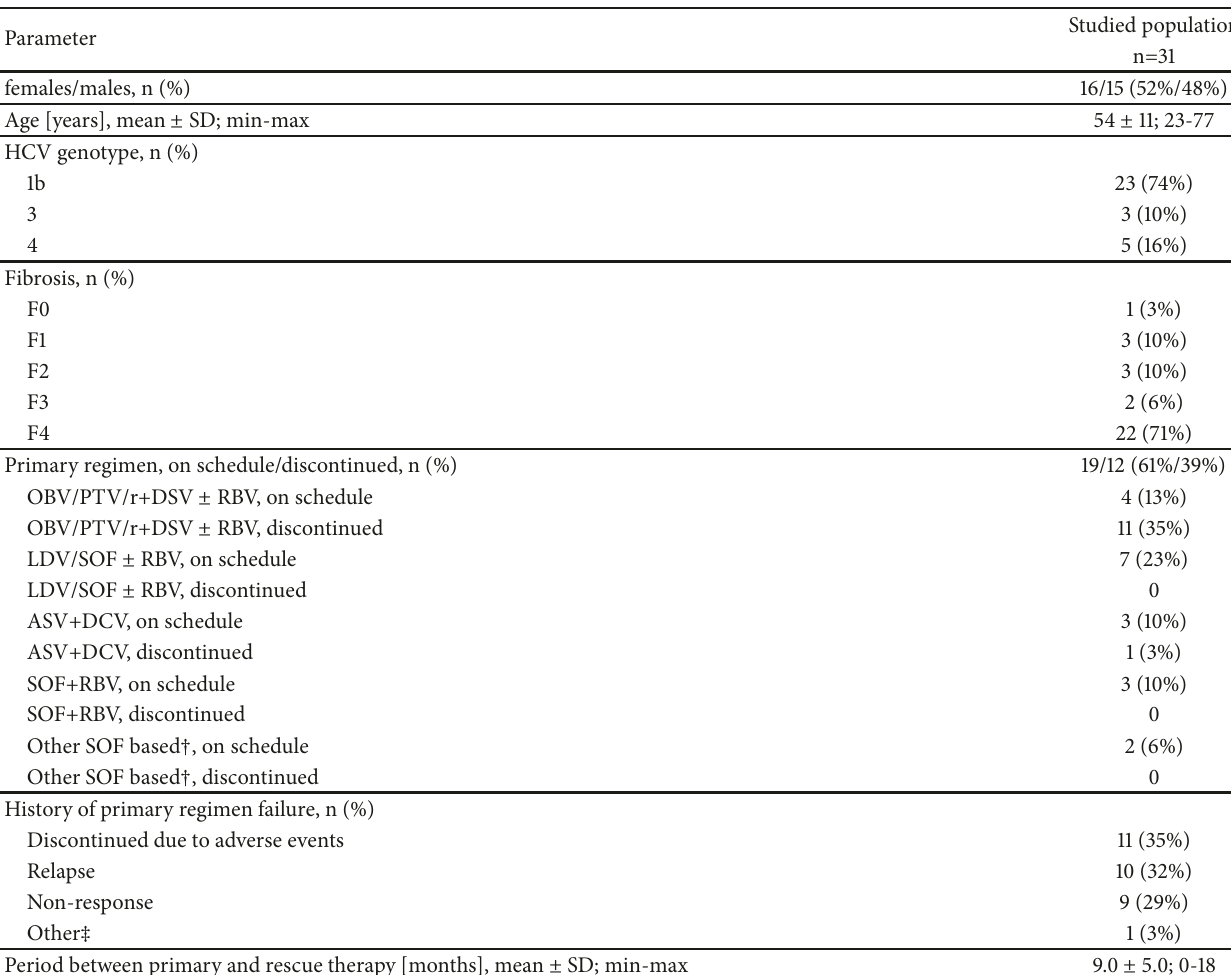
Table 1: Characteristics of nonresponders to interferon-free therapy retreated with genotype specific DAA regimens, compared to the whole population of patients included in the EpiTer-2